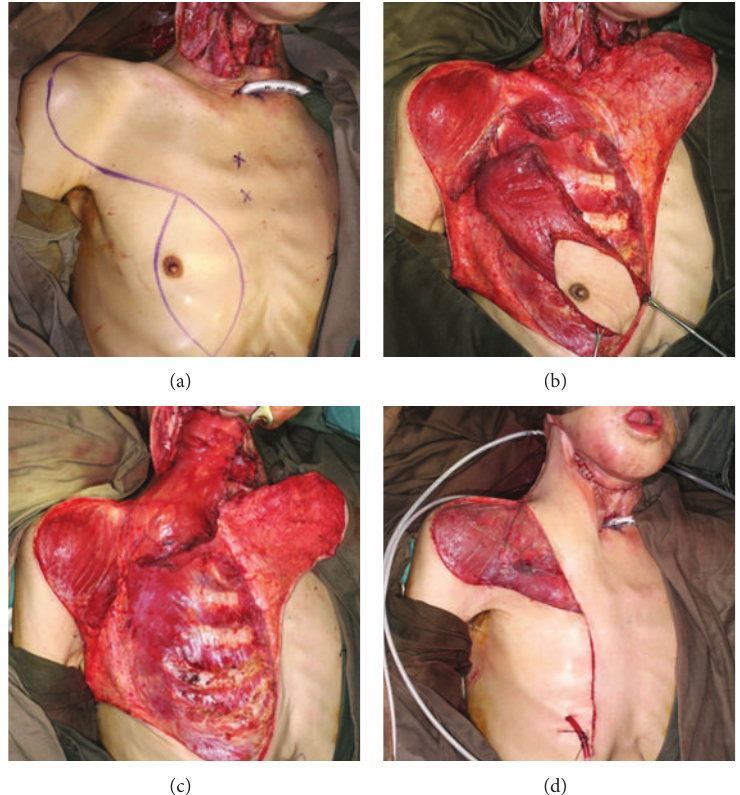
Figure 4: Simultaneous use of DP and pectoralis major (PM) flaps in a patient with partial laryngectomy and neck skin defects. (a) Incisions of skin island of PM flap planned so as to preserve the intercostal perforators supplying the DP flap. (b) Both flaps are raised. (c) PM flap covered the partial pharyngectomy defect; the muscle bulk also protected the major vessels in the neck in case of any leakage. (d) DP flap covered the neck skin defect. Donor site covered with skin